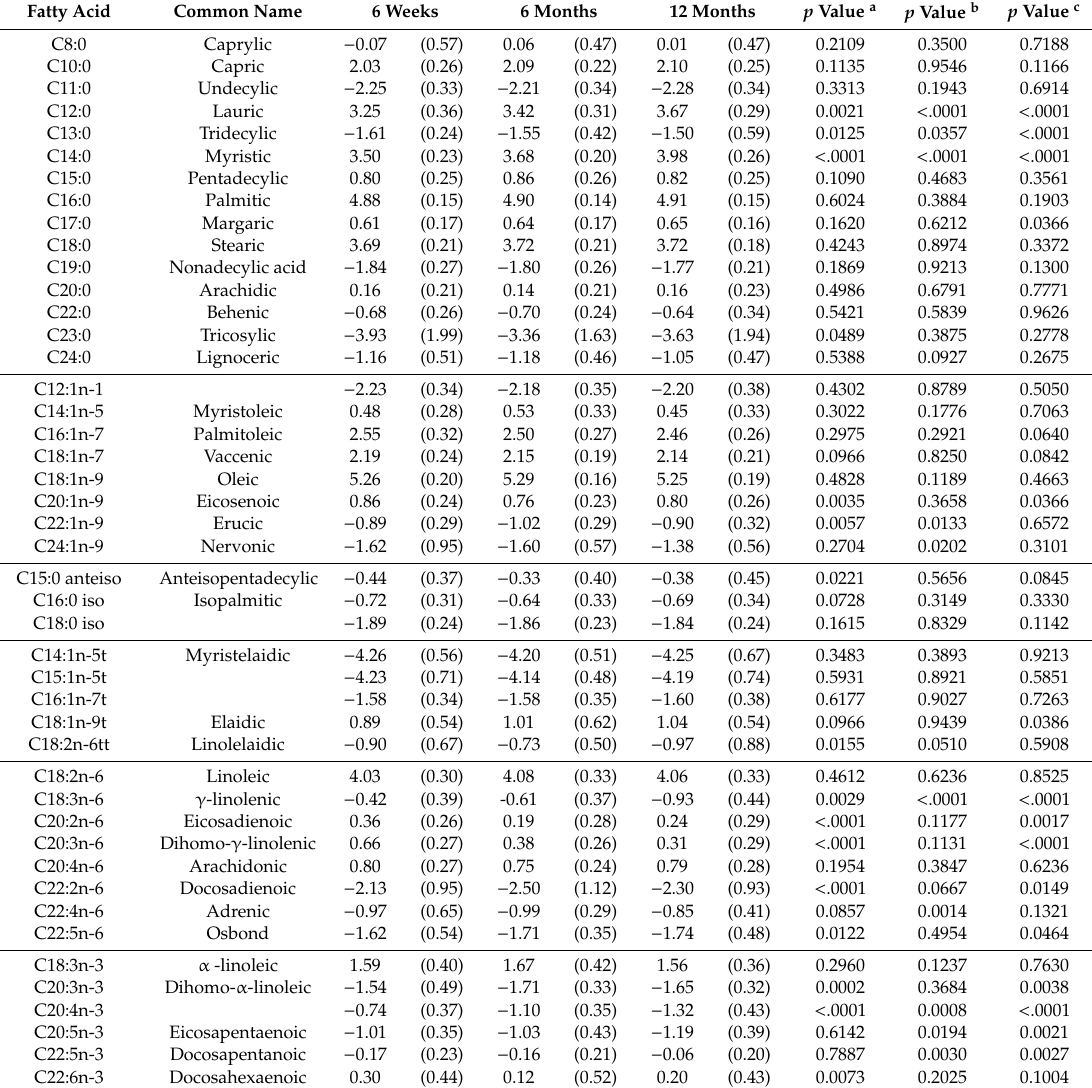
Table 2. Means and standard deviations of centered log ratio (clr)-transformed fatty acid concentrations of human milk samples measured at 6 weeks, 6 months, and 12 months of lactation ( n =